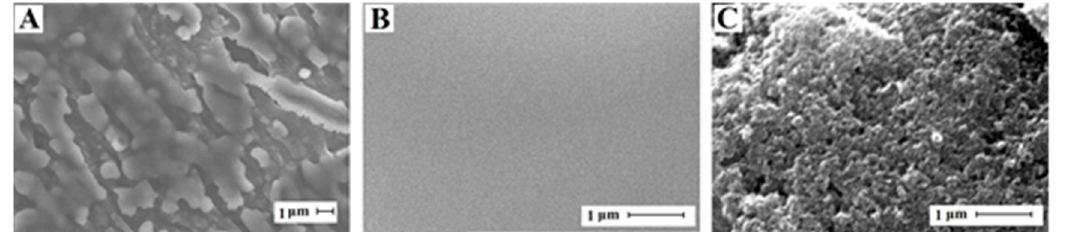
Figure 3. The scanning electron microscopy (SEM_ images of ( A ) ABPE, ( B ) NIP/ABPE and ( C ) ( C ) MIP/ABPE.